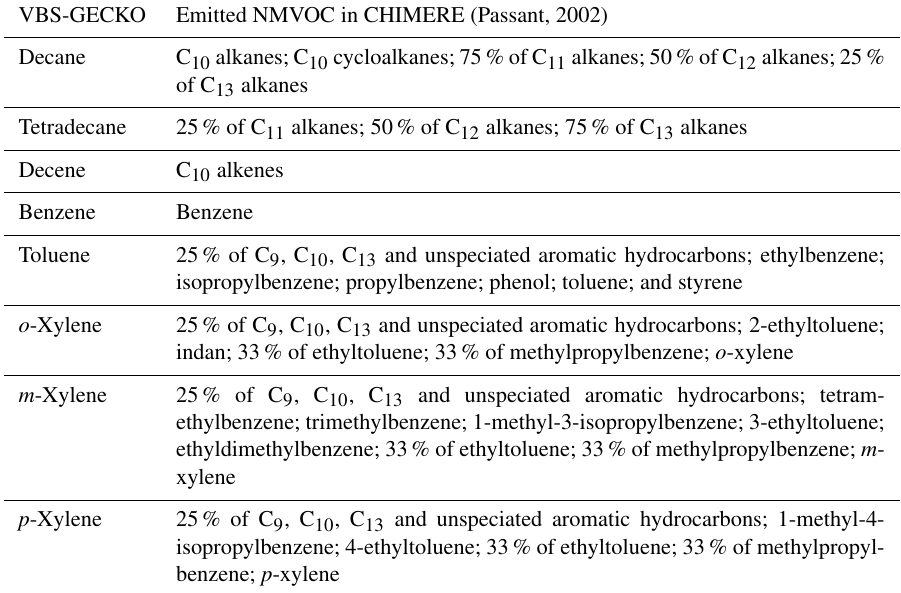
Table 2. Distribution of the NMVOC emission in the VBS-GECKO